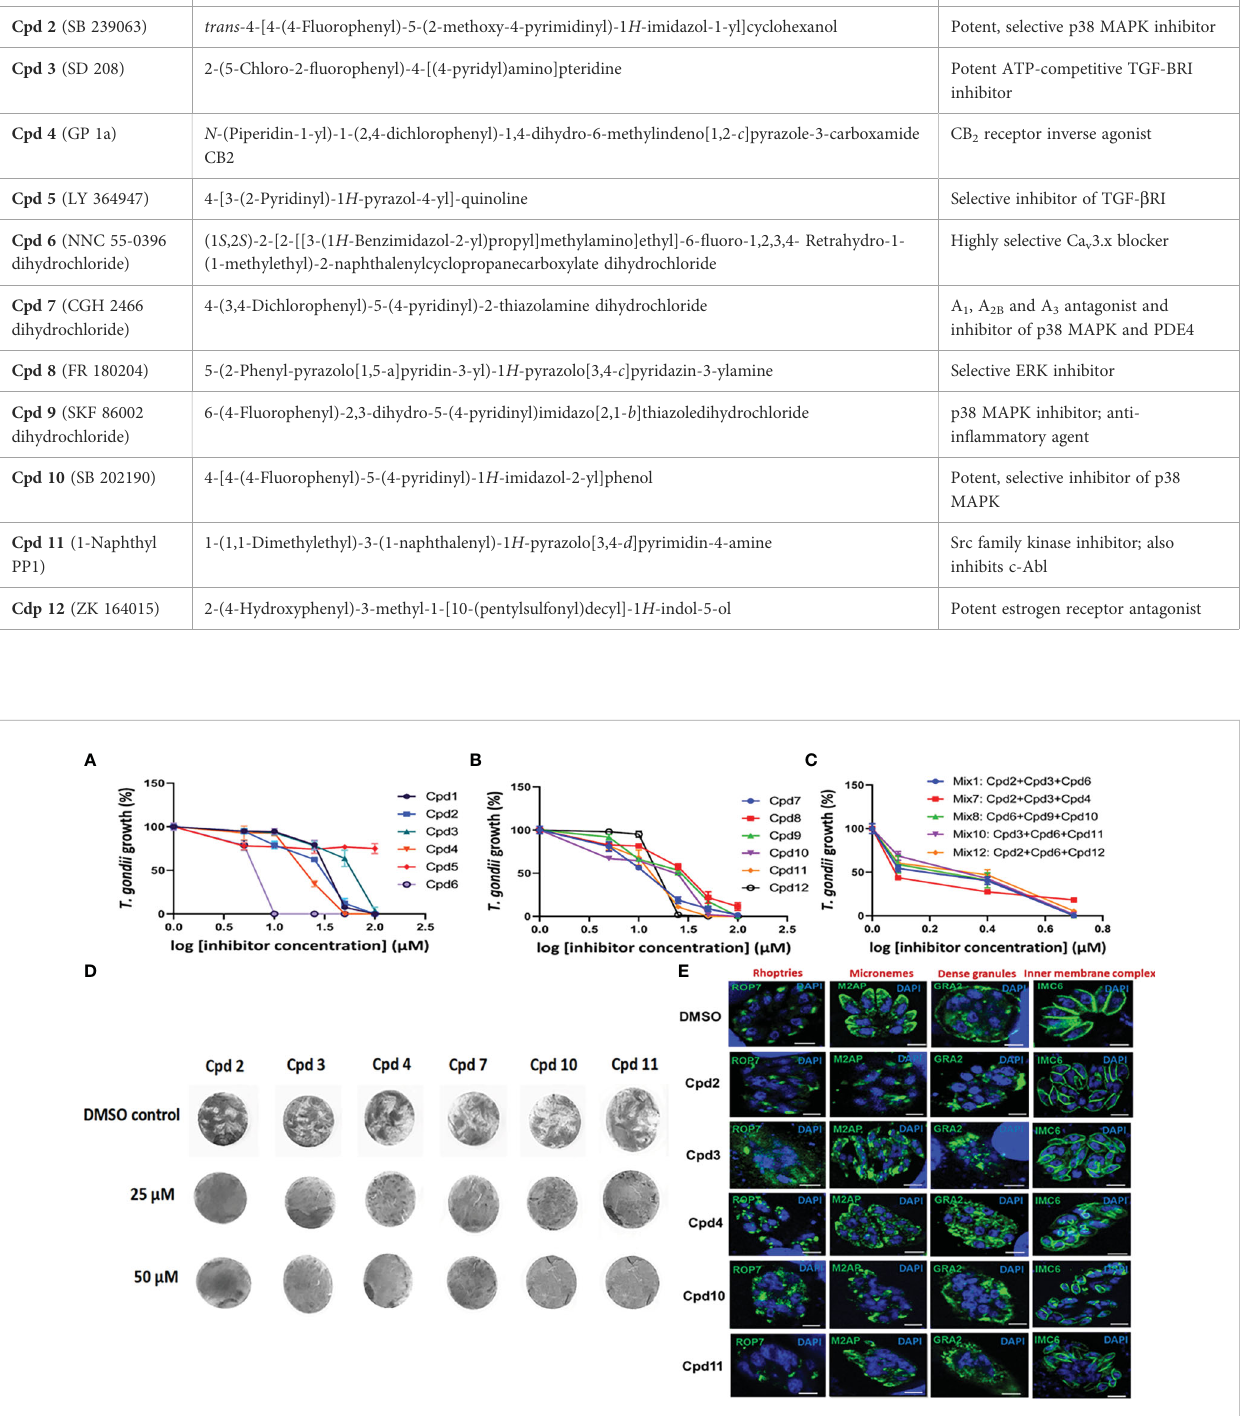
FIGURE 9 Dose-dependent inhibitory activities on the 12 compounds using b -galactosidase assays. Panel (A) shows the assays performed on the fi rst six compounds (including Cpd5, which probably represents a false positive). Panel (B) illustrates the six remaining compounds. These two panels correspond to single-dose assays and all p values are below 0.0001. Panel (C) pertains to a mix of three compounds (p value = 0.0024), while Panel (D) shows a dose-dependent inhibition of plaque formation by T. gondii after nine days of drug exposure. As two independent experiments yielded identical results, one is illustrated here. Panel (E) showing confocal microscopy of intracellular tachyzoites treated with 25 µM of drugs indicated on the images for 24h followed by staining with different antibodies speci fi c to rhoptries, micronemes, dense granules and the inner complex membrane. The control corresponds to intracellular parasites treated with DMSO alone. Nuclei are stained with DAPI. Bar, 3 µm.